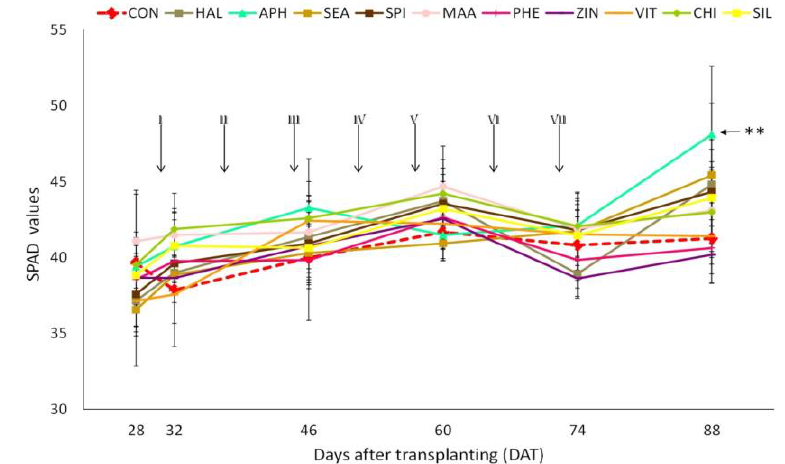
Figure 4. Chlorophyll content (as SPAD values) dynamics from 28 to 88 DAT (end of growth and production) in strawberry plants treated with different biostimulant products and water (control). Arrows indicate when the 7 biostimulant applications were performed. Vertical bars indicate mean ± SD, n = 4. The asterisk indicates significant differences according to Dunnett’s test. *** P < 0.001; ** P < 0.01; * P < 0.05; no asterisk indicates absence of any significant differences.